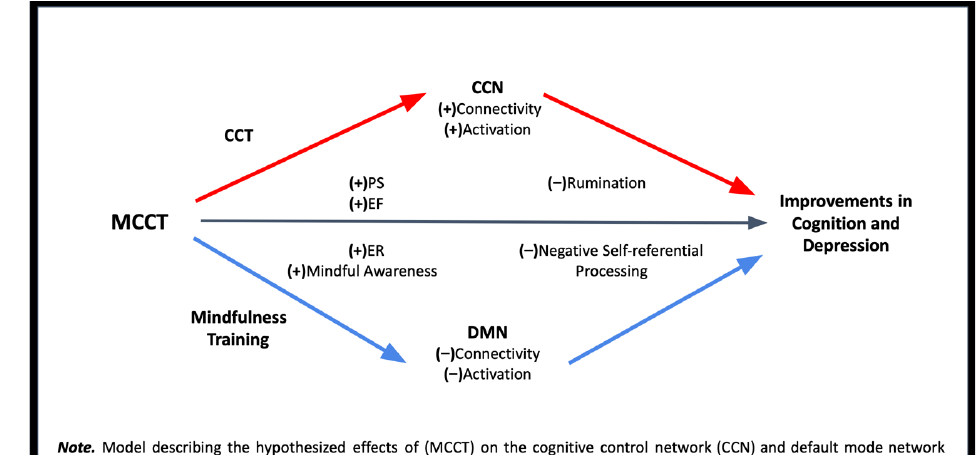
Figure 1. mindfulness-enhanced computerized cognitive training (MCCT). Figure 1. Mindfulness-enhanced computerized cognitive training